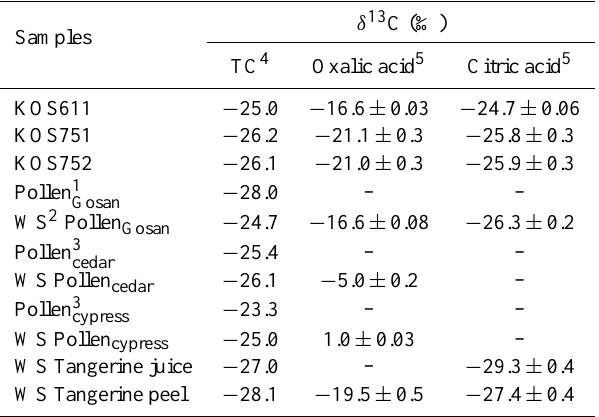
Table 3. Carbon isotope compositions of TC and oxalic and citric acids in selected samples during the pollen episodes, pollens, and tangerine fruit.